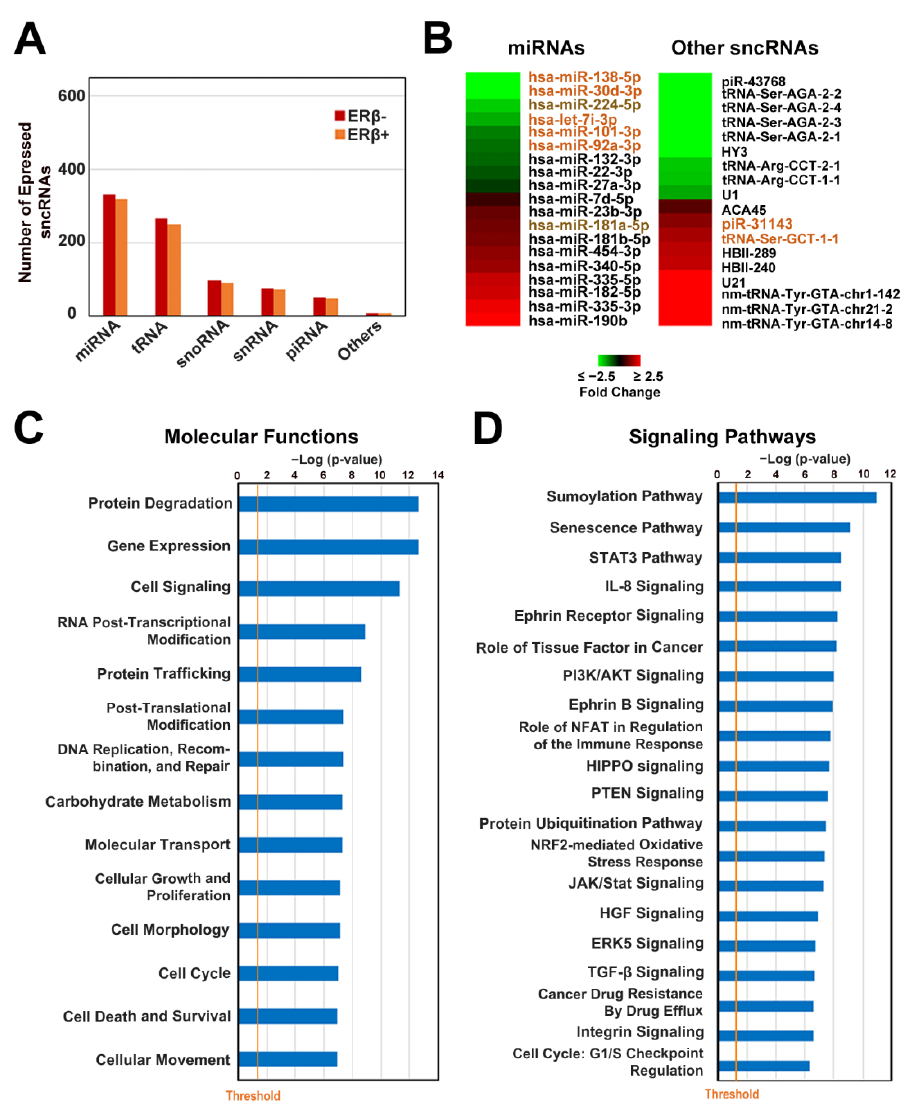
Figure 4. The ER β -induced change in the sncRNA profile in TNBC tissues and its putative e ff ect on molecular processes. ( A ) Histogram showing the number of miRNAs, tRNAs, snoRNAs, snRNAs, piRNAs, and other sncRNAs detected in ER β − and ER β + tissue samples. Only sncRNAs whose median expression level exceeded a minimum threshold (three normalized reads) are reported. ( B ) Heatmaps showing miRNAs (left) and other sncRNAs (right) deregulated in ER β + TNBC tissues ( | FC | ≥ 1.3, p < 0.05). RNAs di ff erentially expressed in ER β + tumor biopsies and three or two cell lines are indicated in brown or orange, respectively. Graphic representation of statistically significant biological functions ( C ) and the top 20 statistically significant signaling pathways ( D ), identified by IPA performed on genes expressed in TNBC tissues and predicted to be targets of miRNAs commonly deregulated both in tissues and at least two of the studied cell lines.